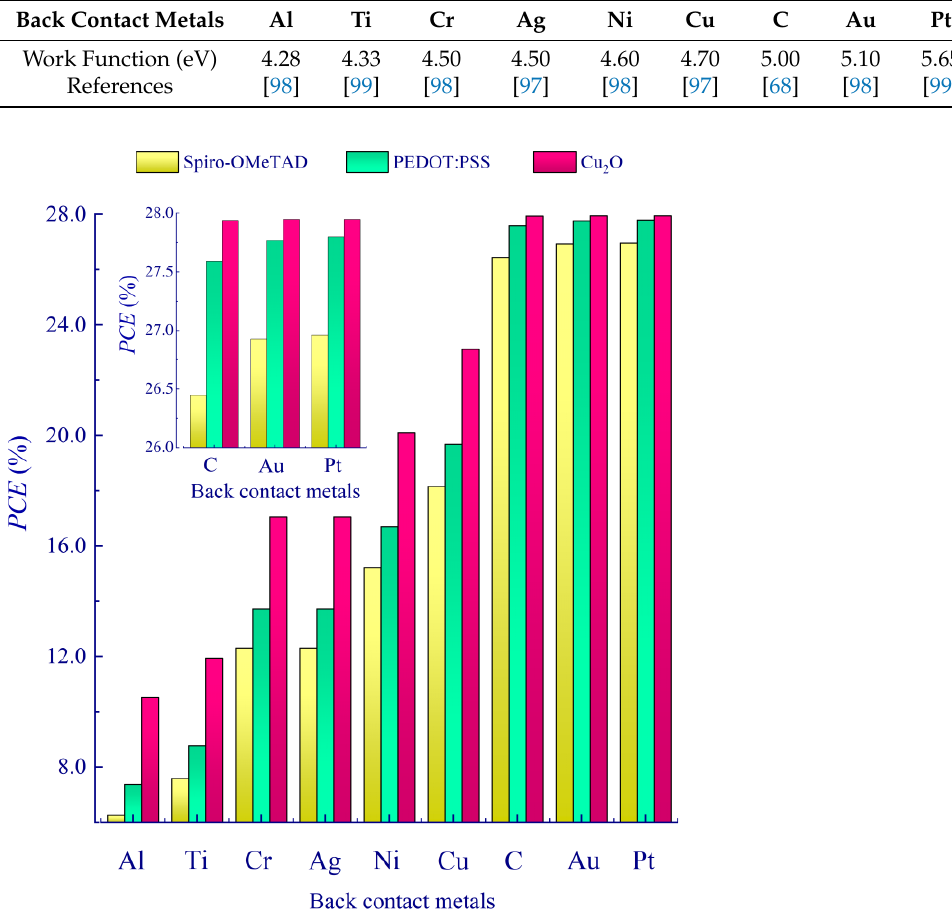
Figure 8. Current-voltage characteristics of perovskite solar cells with different hole-transport layers and a Pt back contact.